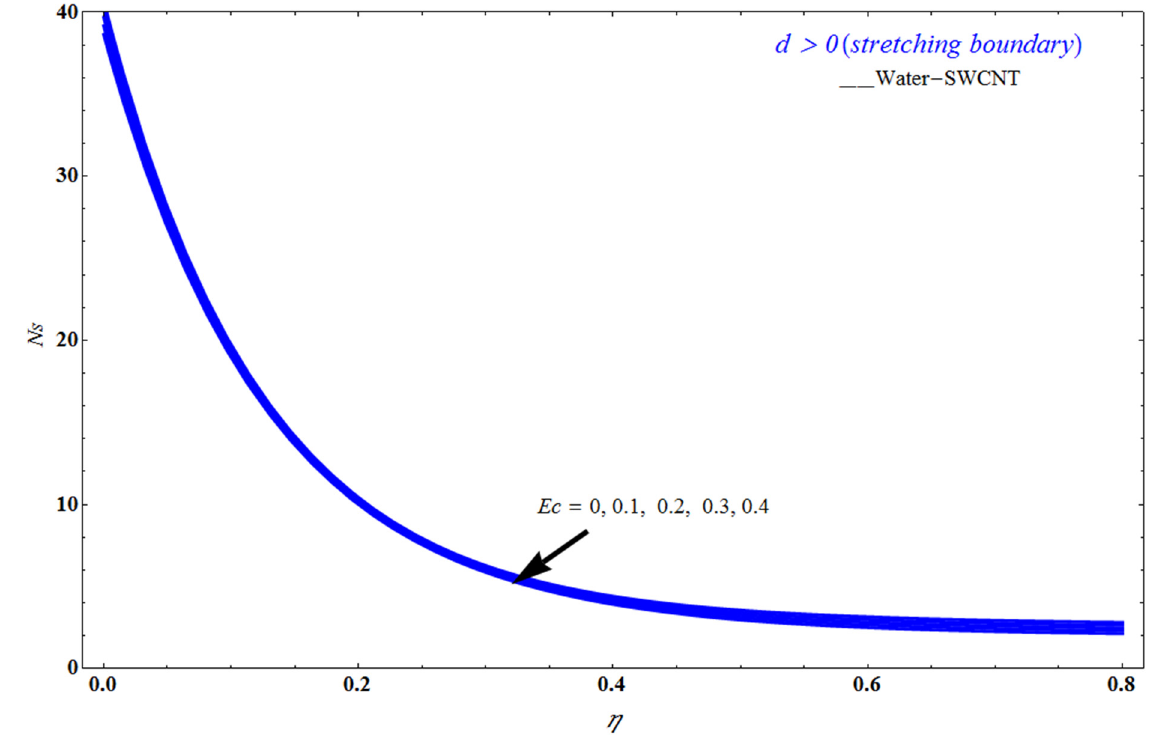
η Figure 18. Influence of Ns on for several values of Ec , respectively. Figure 18. Influence of Ns on η for several values of Ec ,